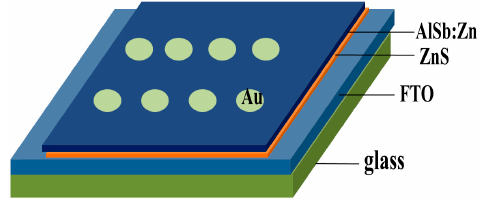
Figure 1. Structure of AlSb-based solar cells.